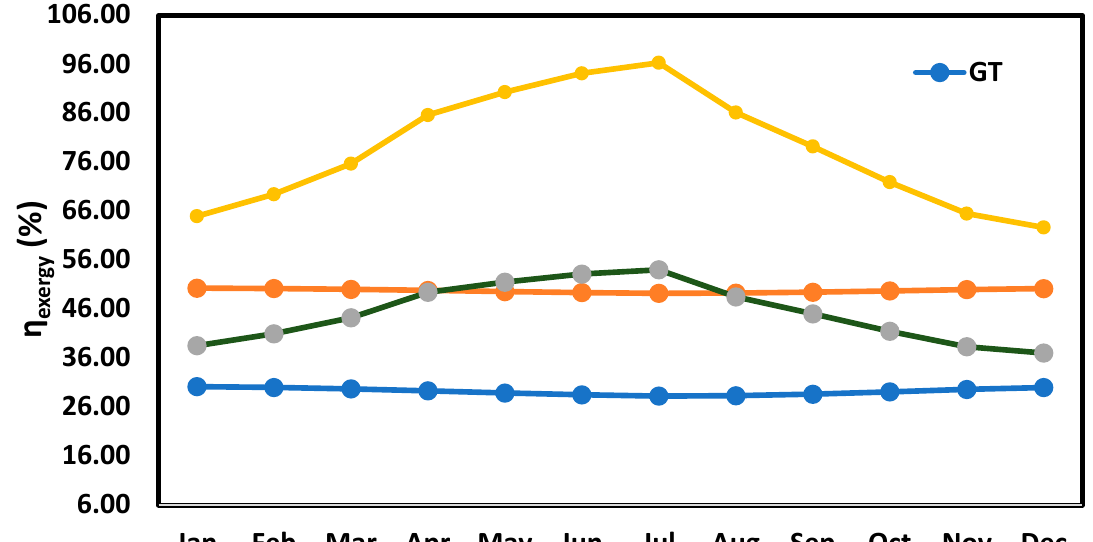
Figure 10. Monthly average of exergy e ffi ciency of four types of GT, GT + HRSG, GT + HSR, and GT + HRSG + HSR.